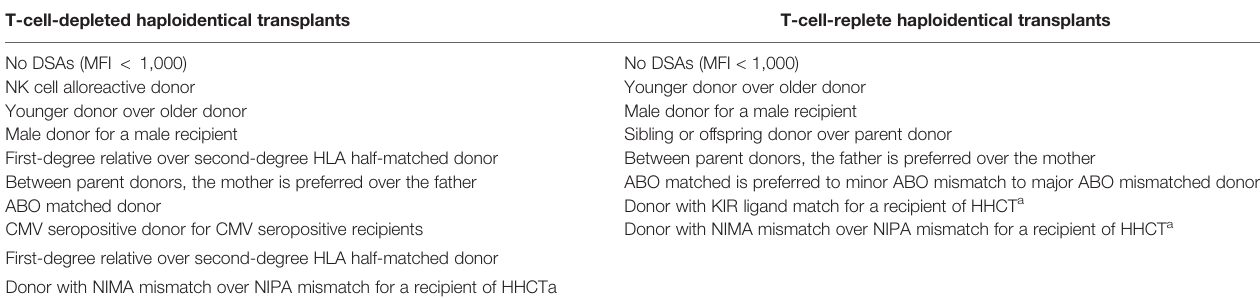
TABLE 2 | EBMT recommendations for haploidentical donor selection, by order. T-cell-depleted haploidentical